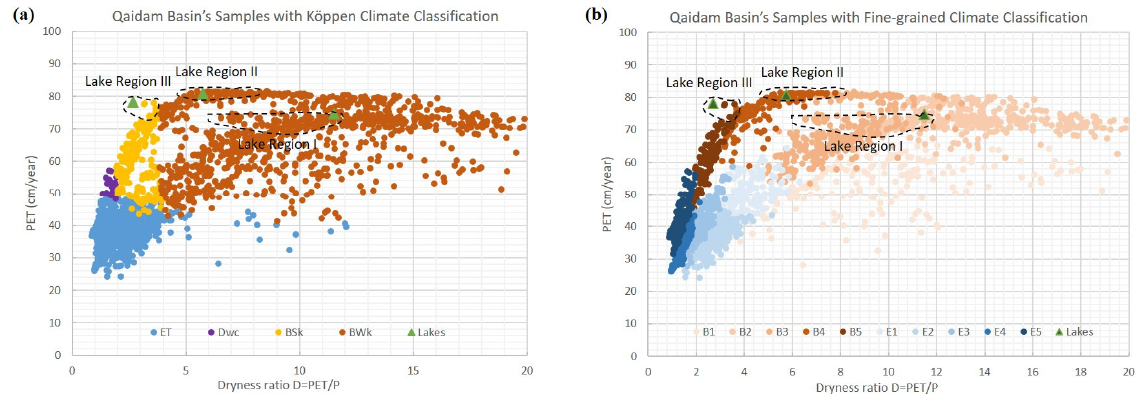
Figure 9. Potential evapotranspiration versus dryness ratio scatter plots for the Qaidam Basin: ( a ) Köppen and ( b ) the fine-grained climate classification. The three lake regions are also included in this feature diagram.